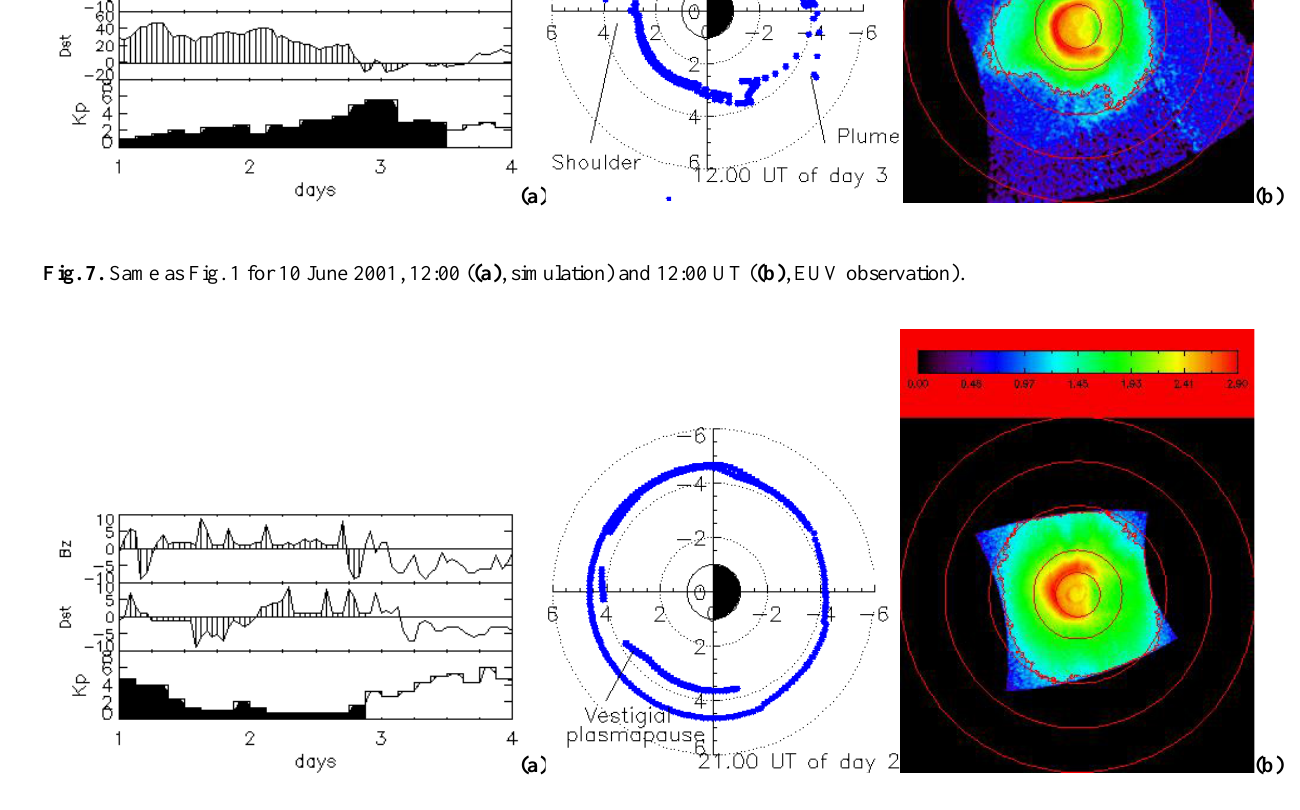
(right panel (b), EUV observation).